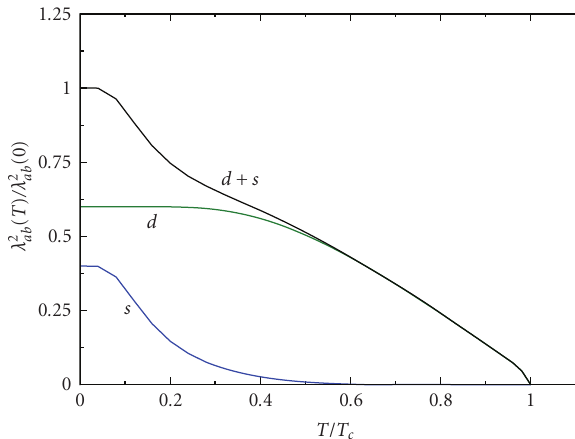
Figure 13: Dependence of the s -wave gap Δ s (squares) and d -wave gap Δ d (circles) on the chemical potential. The red symbols are for 16 O, the blue ones for 18 O.